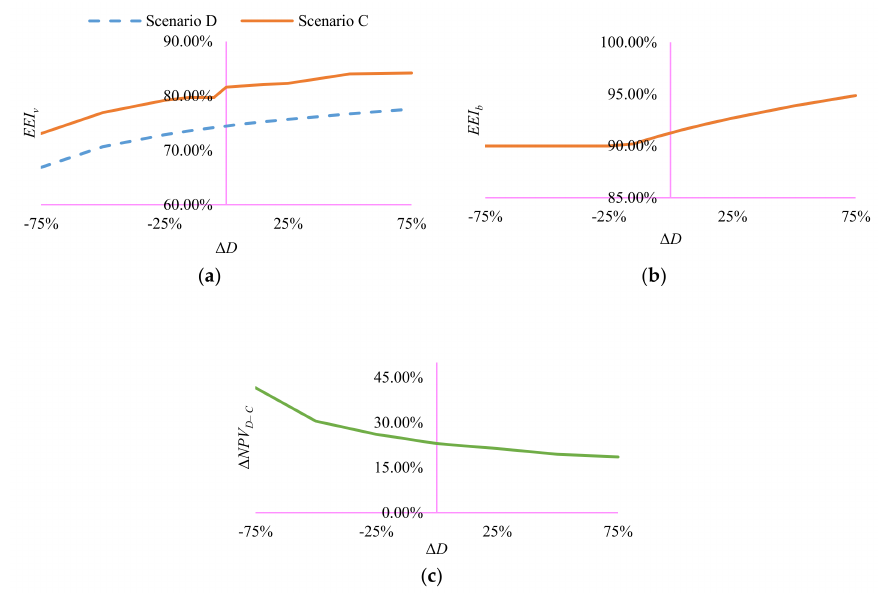
Figure 4. Sensitivity analysis for different demand rates: ( a ) effect on EEI v ; ( b ) effect on EEI b ; ( c ) impact on ∆ NPV D–C shifting from scenario D to scenario